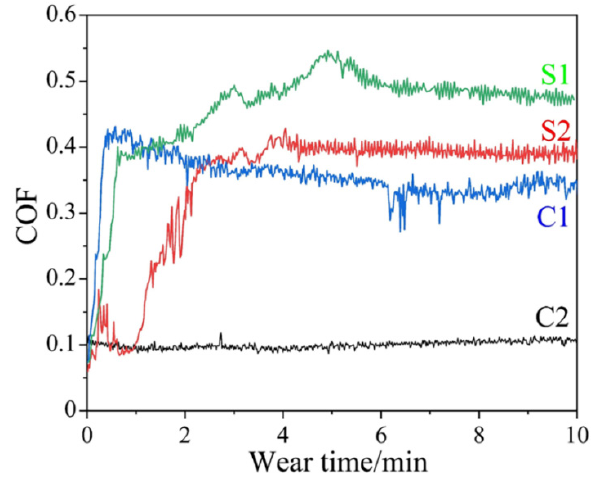
Figure 8. The COF of coatings and substrates.